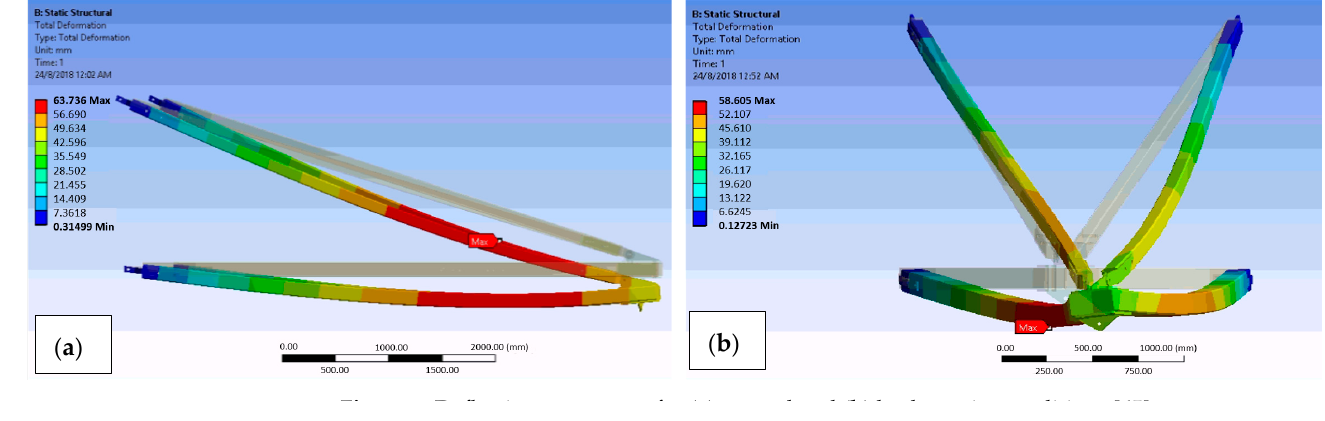
Figure 7. Deflection movement for ( a ) normal and ( b ) broken wire conditions [65]. Table 3. Failure safety factor for each layer in composite cross-arm main beam [65].